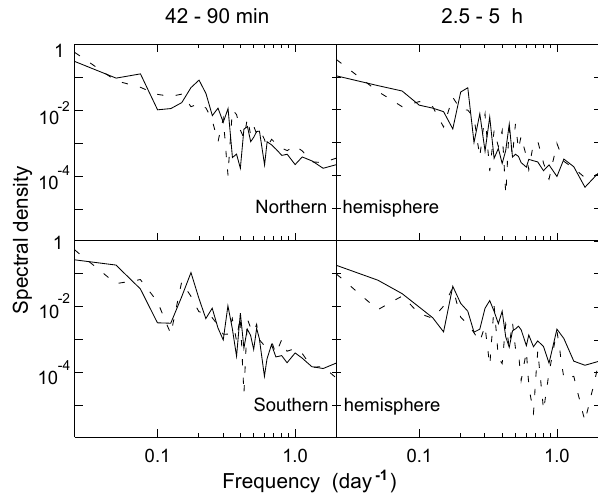
Fig. 7. Cross-correlation coefficients between the components of atmospheric axial angular momentum, associated with zonal wind, for the Northern and Southern Hemispheres and the numbers of prominent peaks in power spectra derived from microbarometer (solid lines) and seismometer (dashed lines) measurements for the period ranges of 42–90min and 2.5–5h.